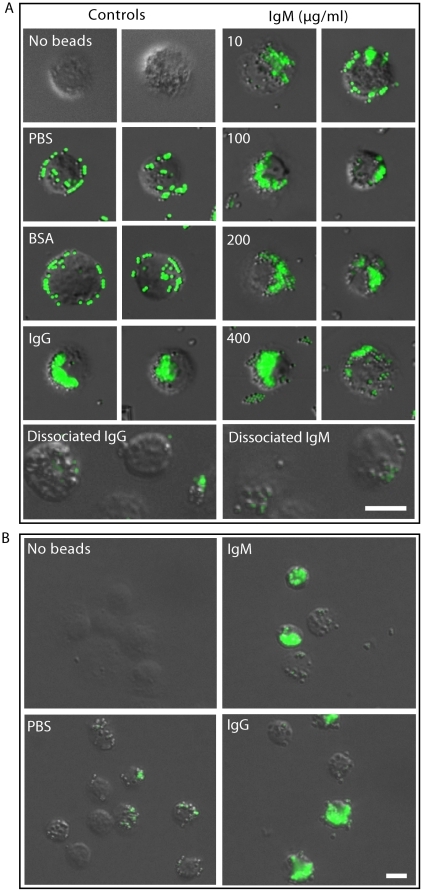
Epifluorescence microscopy reveals that both human and mouse IgM enhance the binding and uptake of small particles by macrophages.(A) Mouse macrophages incubated with human IgM-, human IgG-, BSA-, or DPBS-coated 1 µm beads show distinct fluorescence bead binding or internalization patterns. Left panel shows macrophages and their binding and uptake of beads coated with PBS, BSA (100 µg/ml), IgG (100 µg/ml) or dissociated IgG (100 µg/ml). Right panel shows the uptake of IgM (0–400 µg/ml) or dissociated IgM (100 µg/ml)-coated beads by representative macrophages. Coating of beads with increasing concentrations of IgM shows increasing fluorescence in the macrophages. Dissociating both IgG and IgM eliminates antibody-dependent uptake of these beads by macrophages. Numerical values denote the concentrations of IgM (µg/ml) used for coating the beads. (B) Macrophages phagocytose mouse IgG (100 µg/ml) and mouse IgM (100 µg/ml)-coated small beads (1 µm). Both human (A) and mouse (B) antibodies show similar effects. Scale bar is 10 µm.